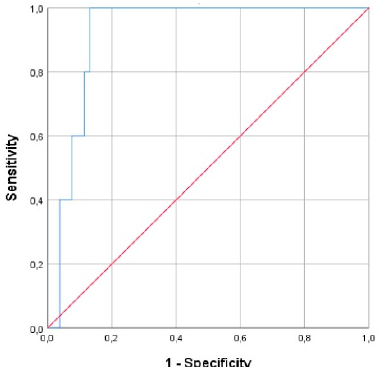
Figure 3. Area under the ROC curves of NRBCs for mortality prognosis in preterm neonates with sepsis. Contrarily, ROC curve analysis showed that NRBCs could not discriminate diagnosis or prognosis of sepsis or perinatal hypoxia between the term neonates of our study. 4. Discussion In the present study, we evaluated the role of NRBCs count in the diagnosis and prognosis of morbidity and mortality in critically ill neonates. Our results revealed that NRBCs could serve, among others, as prognostic and diagnostic markers in this population, especially in preterm neonates.In healthy adults, NRBCs are not present in the peripheral blood but studies have reported